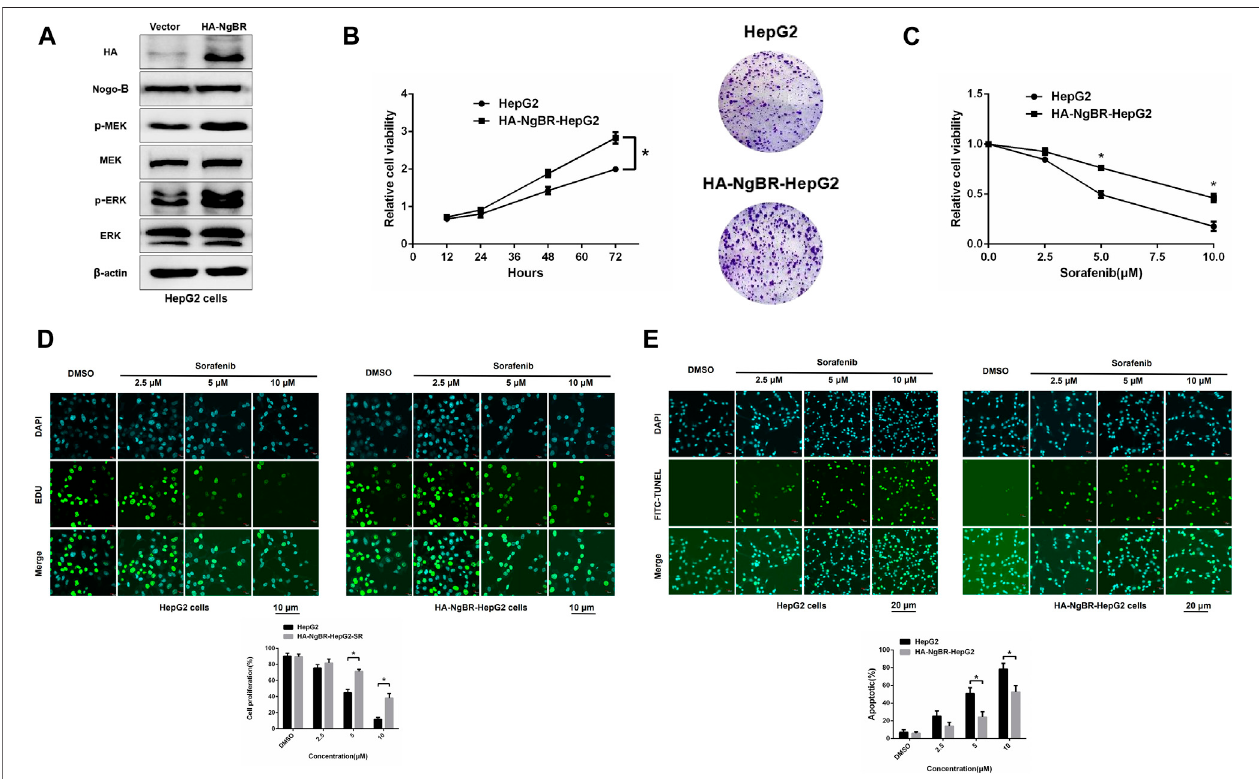
FIGURE 4 | NgBR overexpression promotes sorafenib resistance in liver cancer cells. (A) . NgBR overexpression was assessed via western blotting. (B) . Cell growthinNgBRoverexpressionandnormalcontrolHepG2cellswasdetectedbyMTT(72 h)andcolonyformation(14 days)assays.Thedataarepresentedasmeans ± standard deviation (SD). (C) . MTT assay was employed to evaluate cellular proliferation, as a measure of sorafenib sensitivity in the cells, after 48 h. (D) . Cell proliferation was detected by EDU assays. Scale bars, 10 μ m. (E) . Apoptosis was detected by FITC-TUNEL staining assays. Scale bars, 20 μ m. Experiments were repeated three times and data are presented as mean ± SD. Student ’ s t -test was used for data analysis. * p <